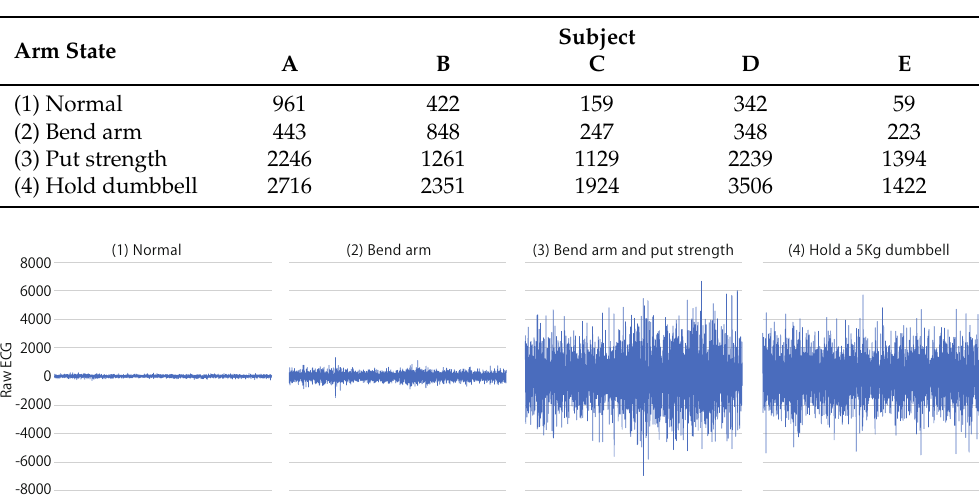
Table 3. RMS of EMG for four muscle activity states.